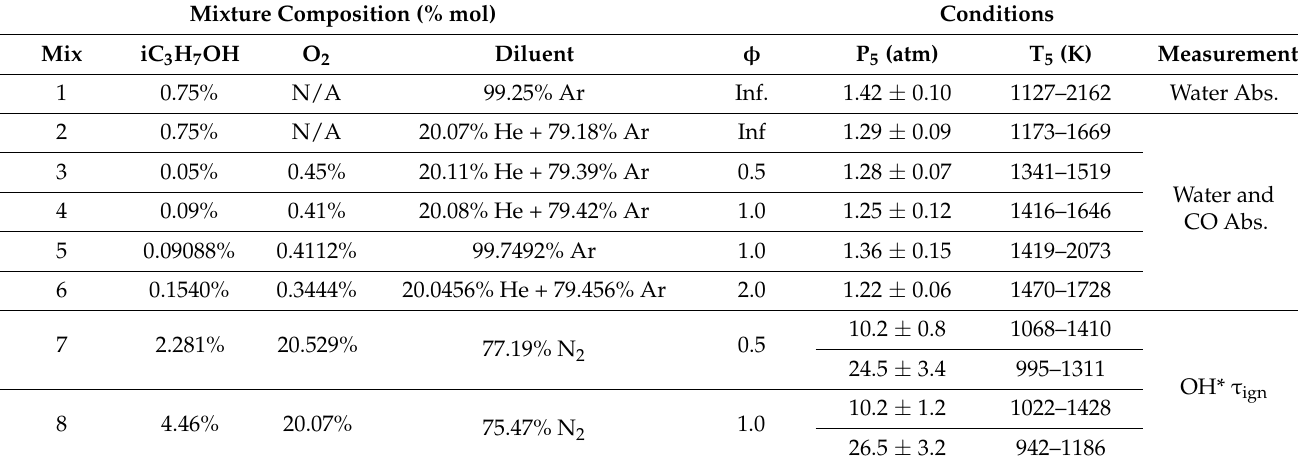
Table 1. Summary of the mixtures and conditions investigated herein. Note, pressures are listed as the average and depict the range of test-to-test variation not the